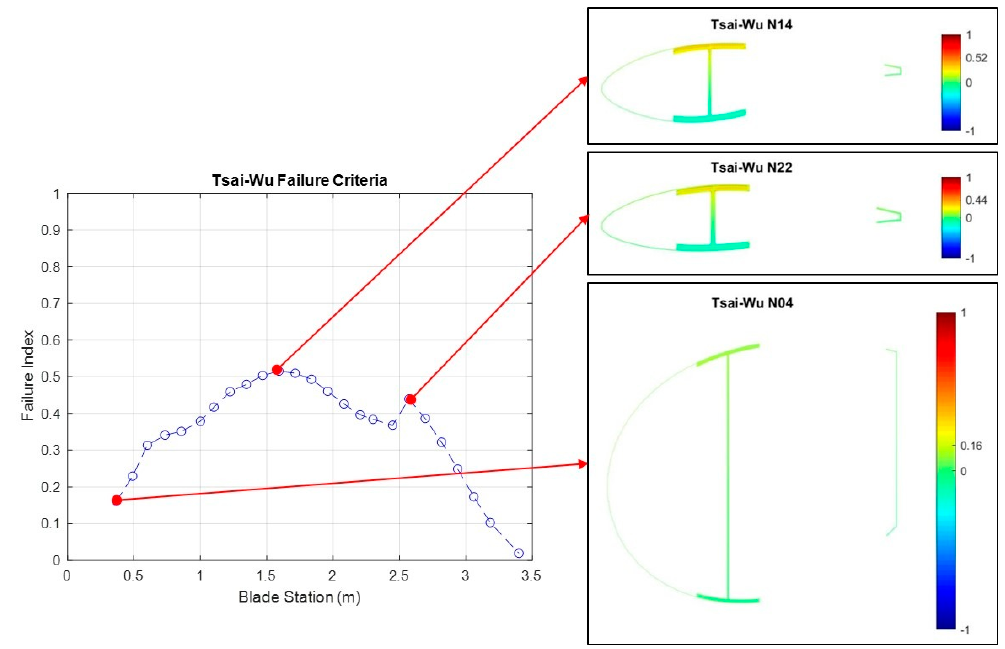
Figure 8. The maximum failure indexes of the cross-sections along the blade span.